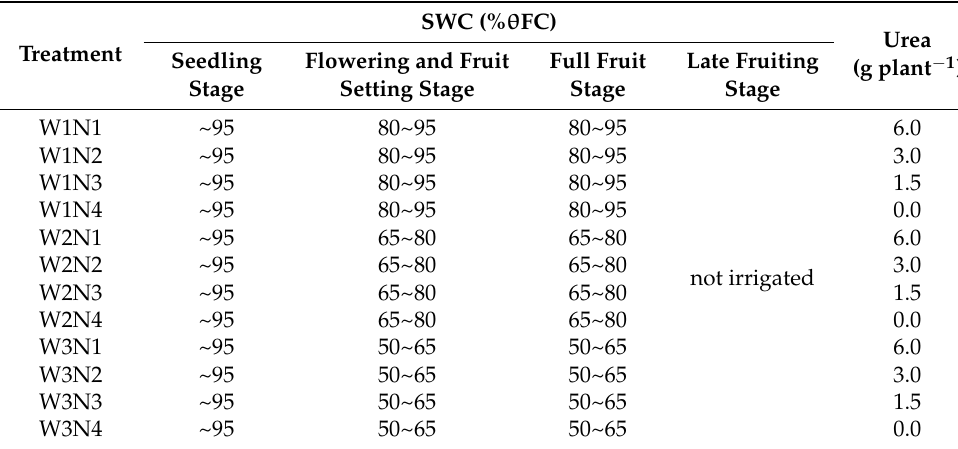
Table 2. The soil water content and urea applied in each growth stage of green pepper. SWC (% θ FC) Urea Treatment Flowering and Fruit Full Fruit Late Fruiting (g plant − 1 )Seedling Stage Setting Stage Stage Stage W1N1 ~95 80~95 80~95 6.0 not irrigated